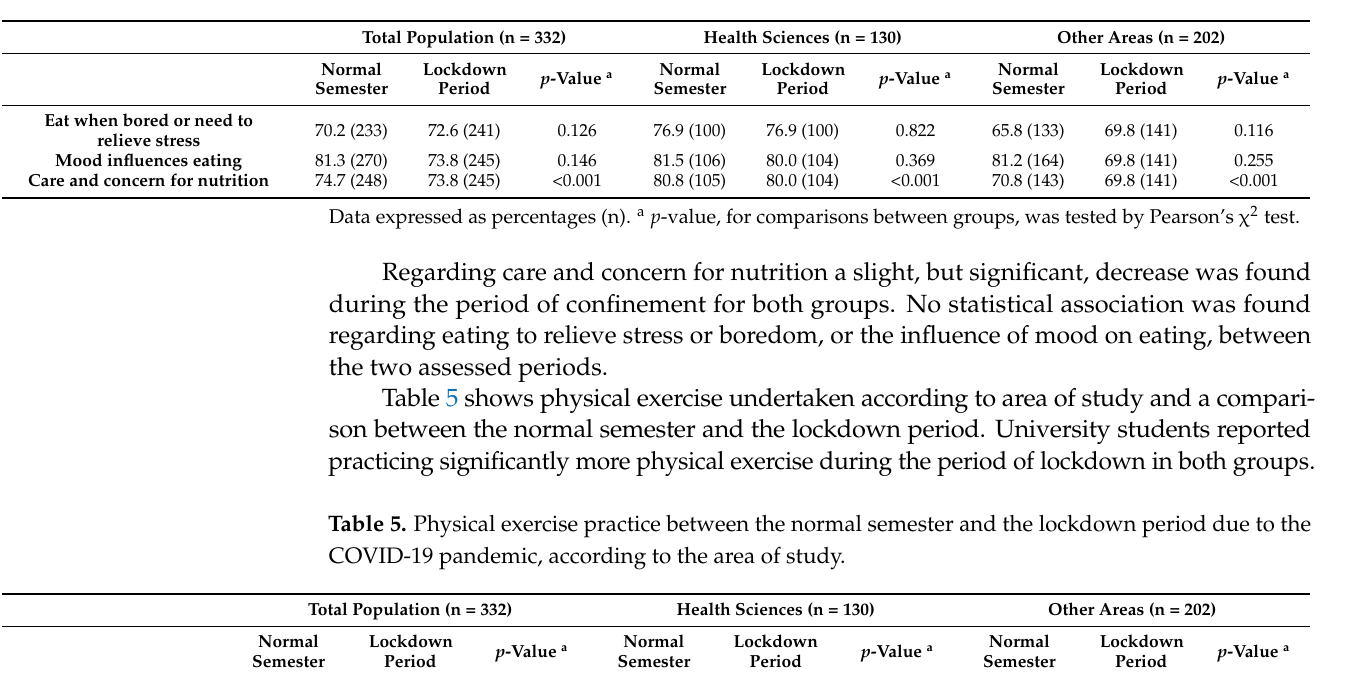
Table 4. Eating habits influenced by emotions between the normal semester and the lockdown period due to the COVID-19 pandemic, according to the area of study.